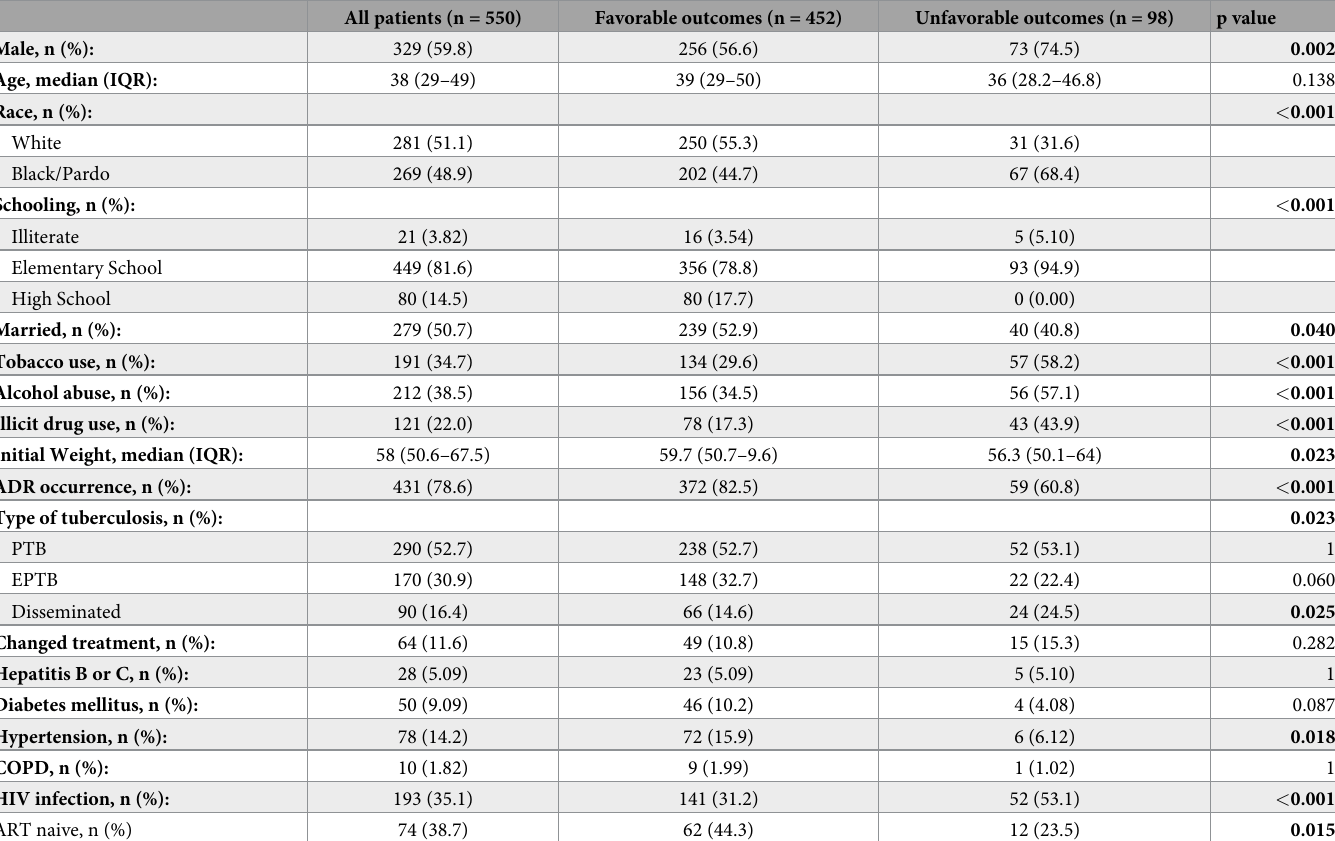
Table 1. Clinical, sociodemographic and comorbidities of tuberculosis patients according to